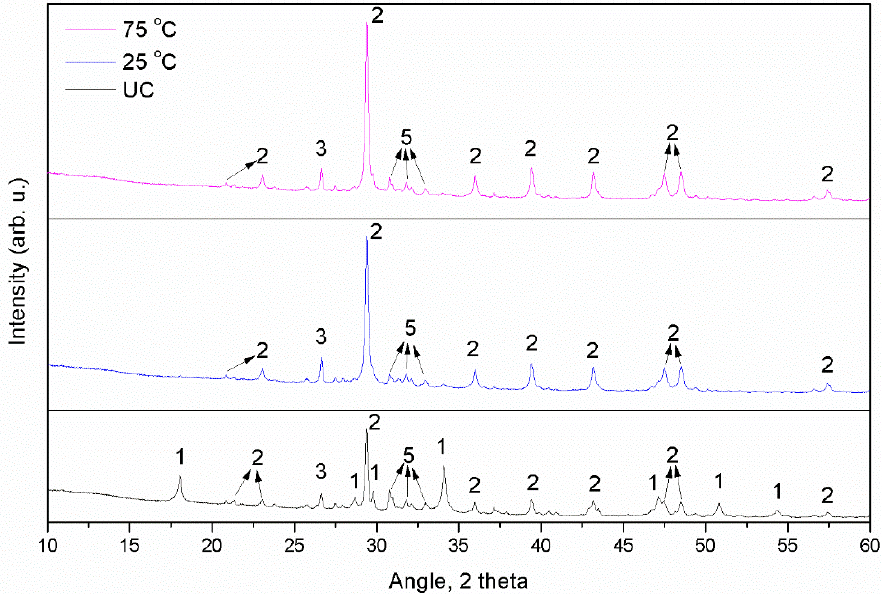
Figure 19. XRD patterns of WA hydrated uncarbonated (UC), cured at 25 °C and 75 °C: 1 — Portlandite; 2 — Calcite; 3 — Quartz; 5 — CSH.